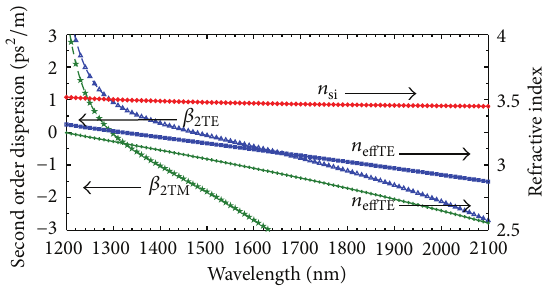
Figure 2: Wavelength dependence of 𝑛 𝛽 2 TM for the fundamental TE mode and fundamental TM mode using the waveguide shown in Figure 1 with 𝑊 = 0.7 𝜇 m and 𝐻 = 0.5 𝜇